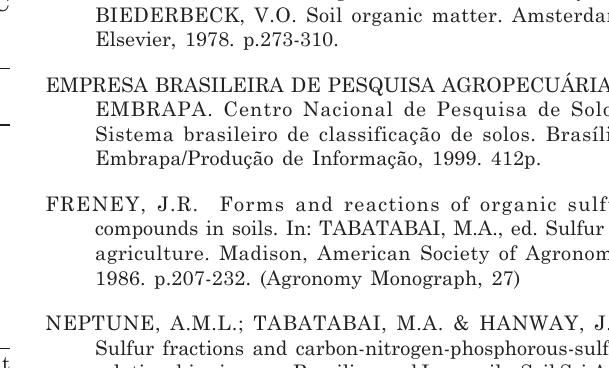
Means between treatments in the rows, followed by different letters are different from each other at the 5 % level by Tukey